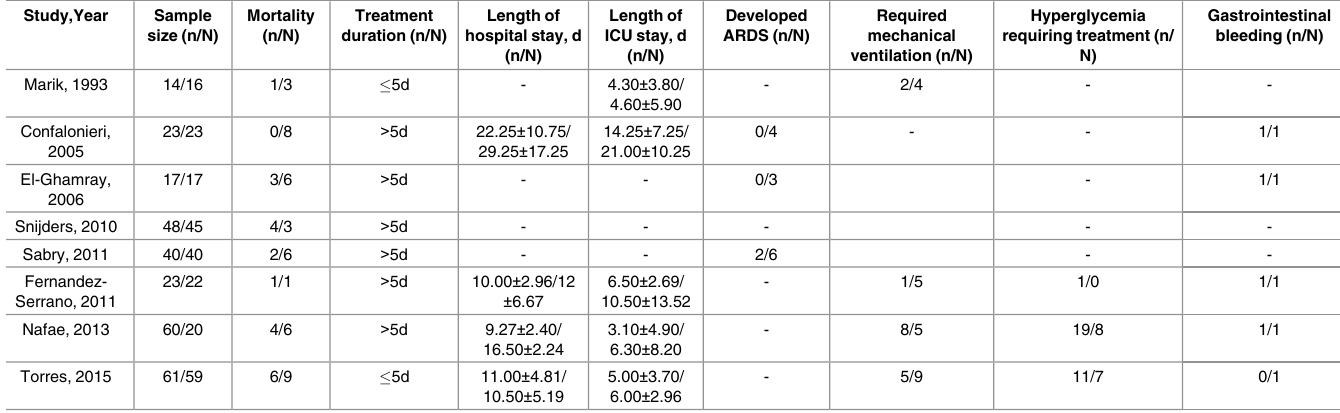
Table 2. Outcome data per study. Study,Year